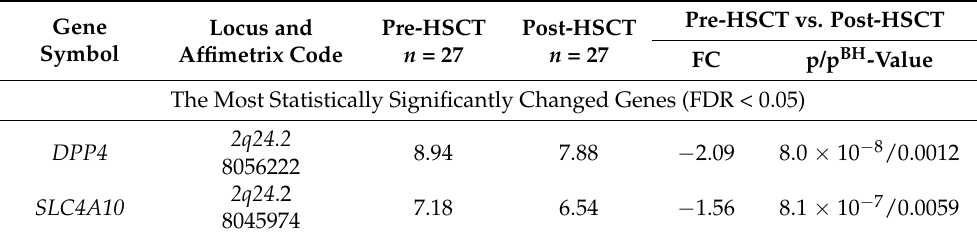
Figure 1. Identification of the genes with different expressions before and after HSCT. ( A ) Boxplot showing the signal intensity of the raw data obtained when reading a microarray and ( B ) after RMA normalization. ( C ) Volcano plot showing genes whose expressions changed significantly after HSCT. Red dots indicate genes with increased expressions and green dots indicate genes with decreased expressions. ( D ) Scatter plot for 139 identified DEGs. The x-axis shows expressions of genes before HSCT, and the y-axis shows expressions of genes after HSCT. ( E ) Heatmap showing expressions of DEGs. The x-axis shows individual samples, while the y-axis shows individual genes. The colors correspond to log 2 of the intensity of the recorded signal. Table 5. The genes with most significant expression changes after HSCT. The gene expressions are shown as log 2 of signal RMA-normalized